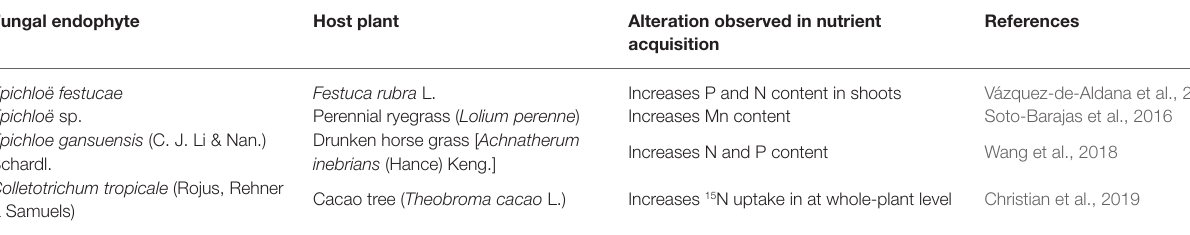
TABLE 3 | Improved nutrient uptake by various endophytic fungi which are not